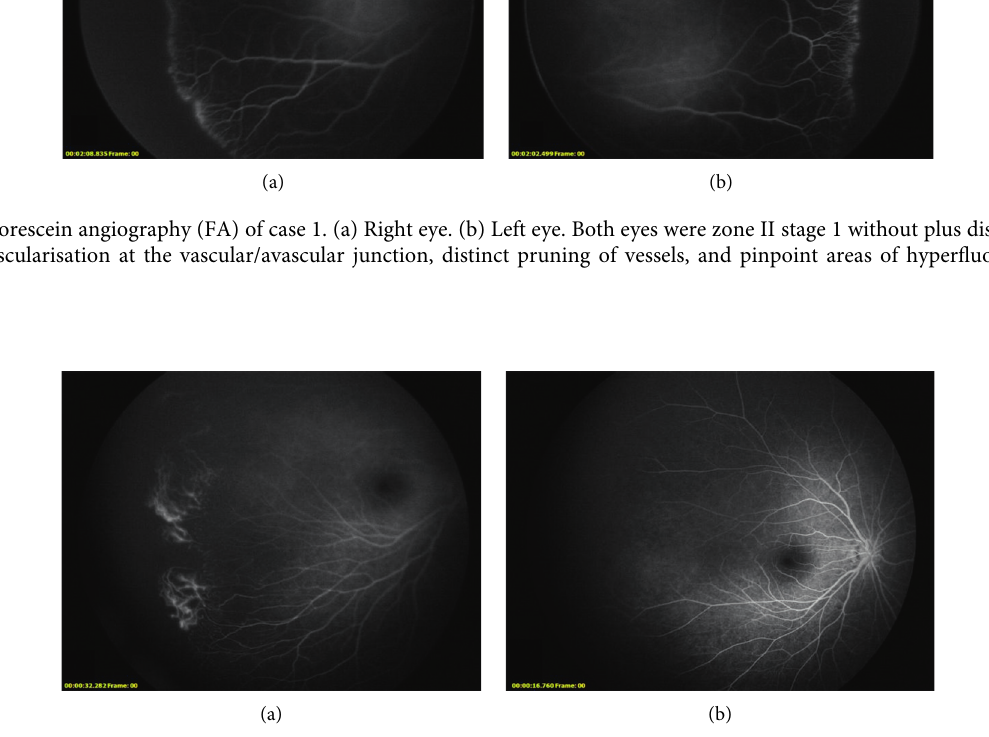
Figure 2: Left eye of case 7. Vascular loops with tangles beyond the edge of vascularisation were observed.